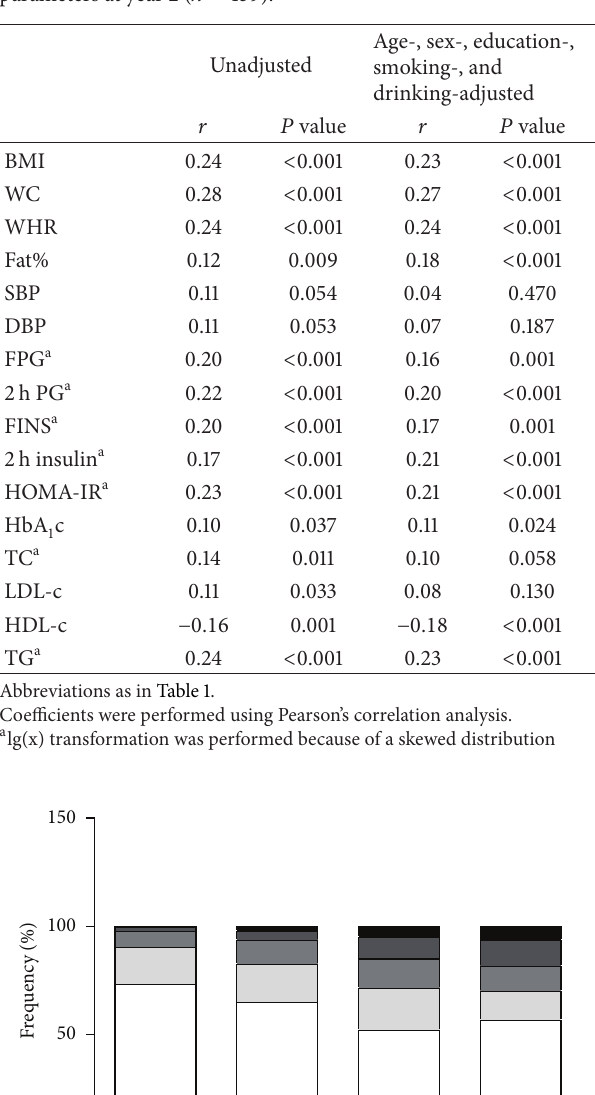
Table 4: Correlations between baseline fractalkine and metabolic parameters at year 2 ( 𝑛 = 459 ).